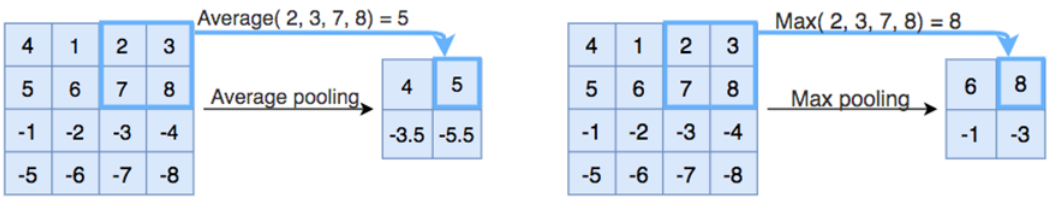
Fig. 2. Principal of convolutional layers